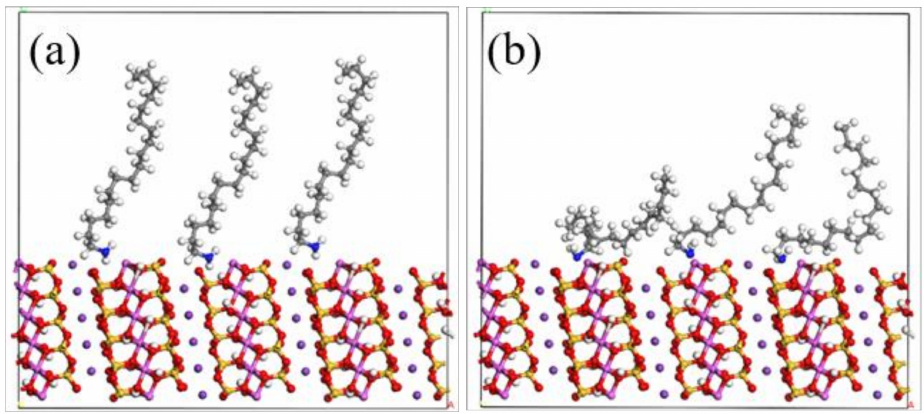
Figure 12. Changes in ODA before and after adsorption on the muscovite (131) crystal plane (( a ) pre-adsorption ( b )